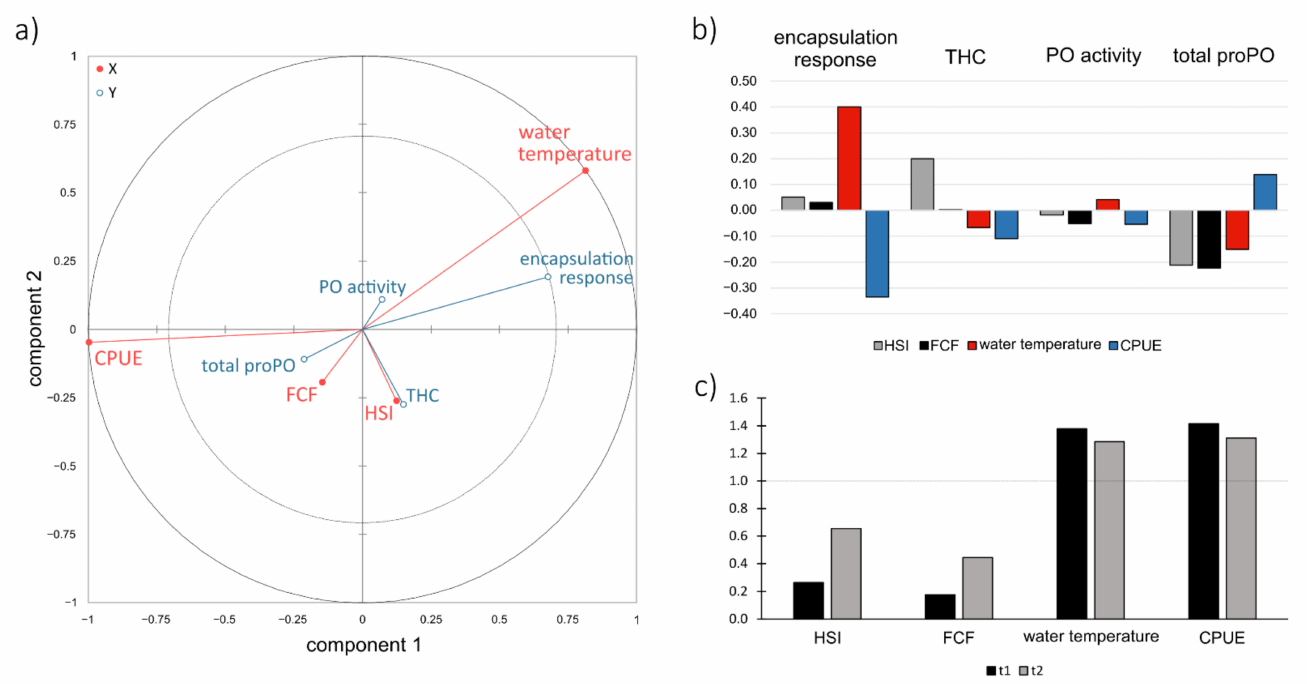
Figure 2. ( a ) Radar of correlation, illustrating the relationship between response variables (signal crayfish immune parameters, represented with blue lines) and predictors (represented with red lines). ( b ) Standardized coefficients of signal crayfish immune response. The closer to the absolute value of 1 the coefficient is, the stronger the effect of that predictor on the response variable (controlling for other variables in the equation). ( c ) Variable importance for the projection (VIP) for explanatory variables of first two components (t1 and t2). VIP > 1 indicate the explanatory variables that contribute the most to the PLS model. CPUE = catch per unit effort (relative crayfish abundance), FCF = Fulton’s condition factor, HSI = hepatosomatic index, PO = phenoloxidaze, proPO = prophenoloxidaze, THC = total hemocyte